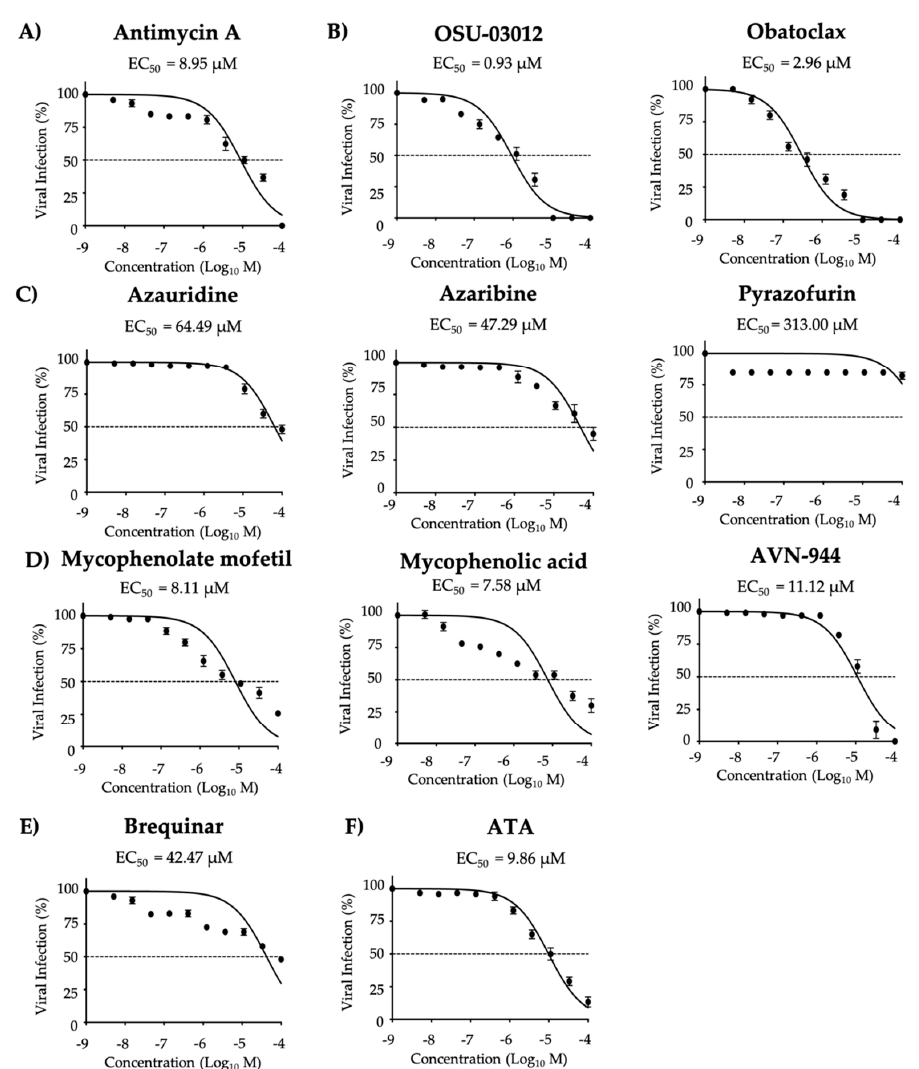
Figure 5. Inhibition of ZIKV Paraiba/2015 replication (pre-treatment): Vero cells in 96-well plate (5 × 10 4 cells/well; quadruplicates) were treated with infection media (DMEM 2% FBS) containing the indicated concentrations of the compounds (3-folds dilutions, starting concentration 100 µM) ( A ) Antimycin A, ( B ) OSU-03012 and Obatoclax, ( C ) Azaribine, Azauridine, and Pyrazofurin, ( D ) Mycophenolate mofetil, Mycophenolic acid, and AVN-944, ( E ) Brequinar, and ( F ) Aurintricarboxylic acid (ATA). After 12 h of treatment, media was replaced, and cells were infected with Paraiba/2015 (25 PFU/well). After 2 h viral absorption, media was replaced by post-infection media. At 36 h post-infection, cells were fixed and immunoassayed using the anti-E 4G2 mAb. Plaques were counted with an automated ELISPOT reader. Dotted line indicates 50% inhibition. Data were expressed as mean and SD from three independent experiments conducted in